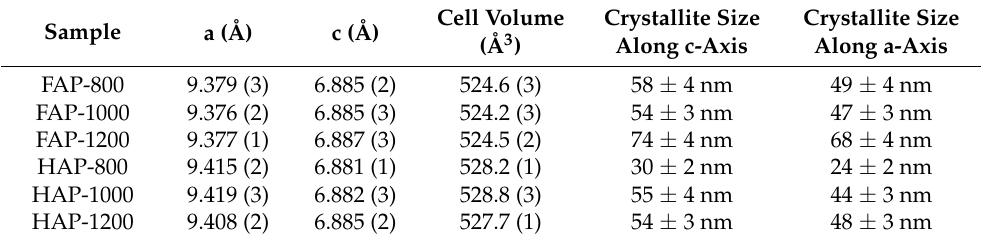
Table 1. Crystal parameters obtained for each sample based on the PXRD diffractograms.